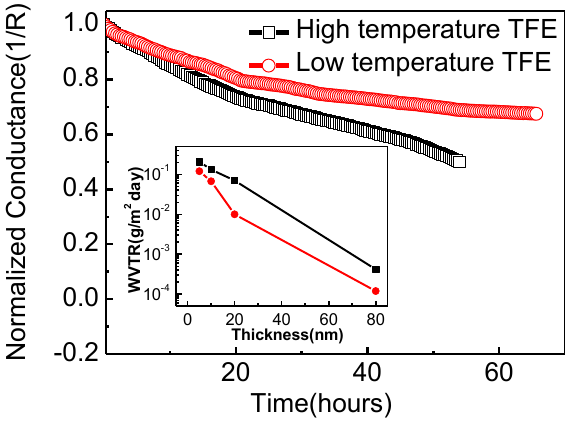
Figure 4. Normalized change in electrical conductance of Ca corrosion tests with (80 °C, PGT = 30 s) Al 2 O 3 and (80 °C, PGT = 30 s) Al 2 O 3 as a function of time at 25 °C and 60% RH; the inset showed Water Vapor Transmission Rate (WVTR) changes with different film